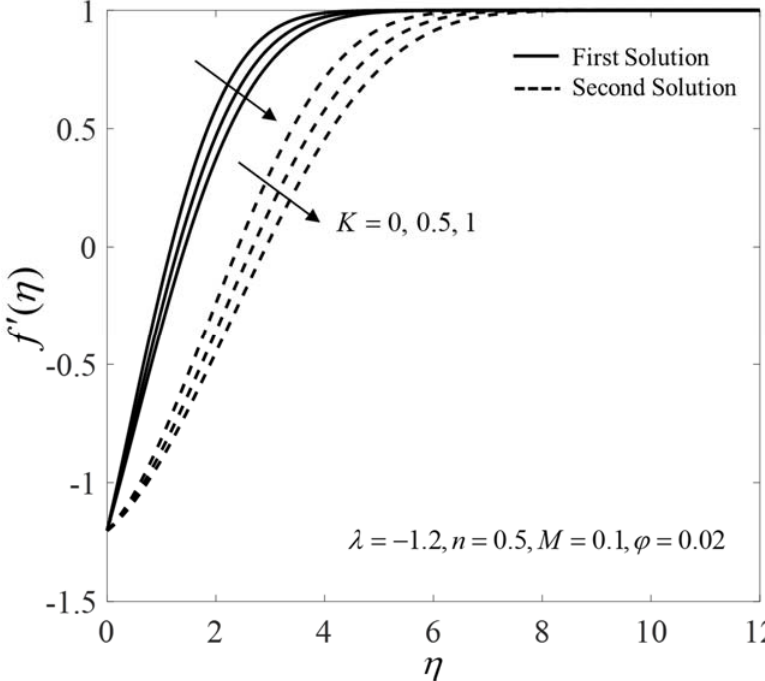
Figure 8. Velocity 𝑓 (cid:4593) (cid:4666)𝜂(cid:4667) for different 𝐾 values. Figure 8. Velocity f (cid:48) ( η ) for different K values.